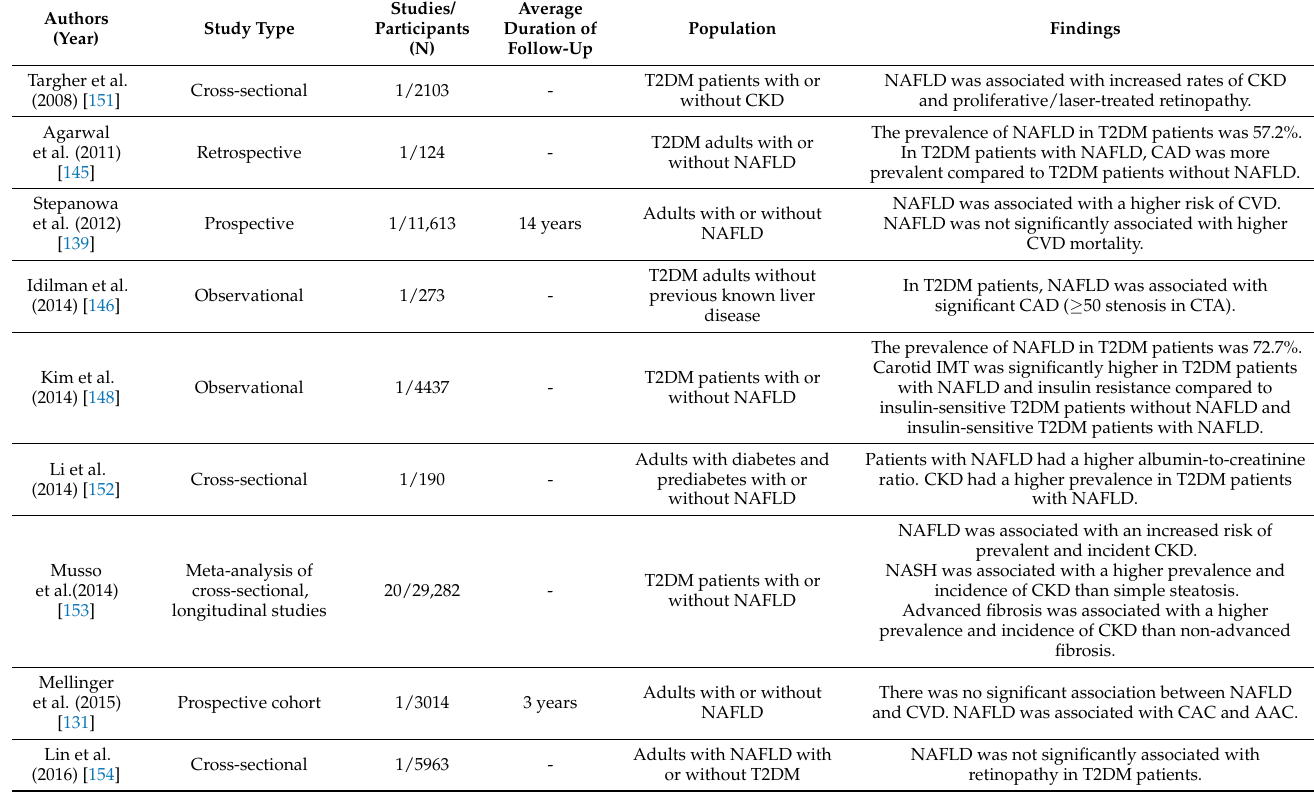
Table 6. NAFLD and cardiovascular